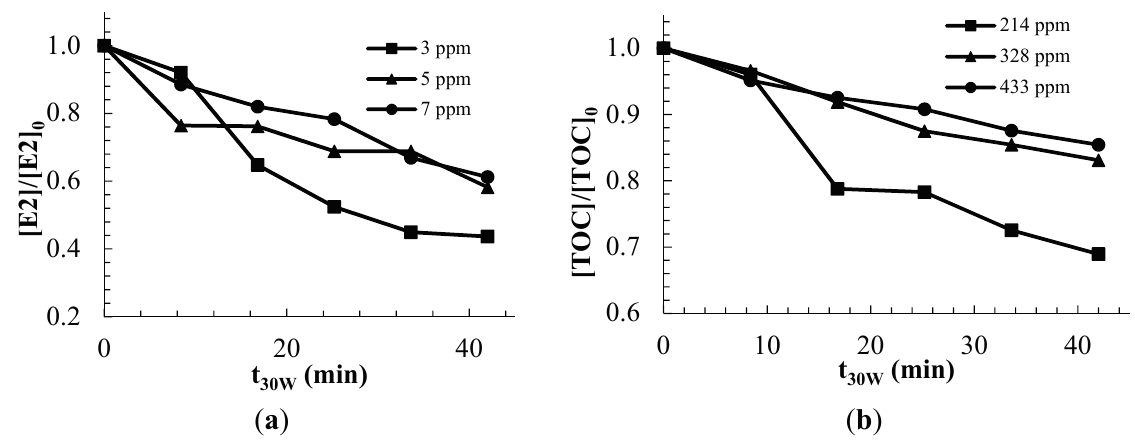
Figure 5. Effect of the initial concentration of the contaminant on the degradation rate with a catalyst load of 0.6 g/L; ( a ) Estrogens degradation; ( b ) TOC removal. The estrogens removal was 56.7%, 41.7% and 38.7% for 3, 5 and 7 ppm of initial estrogens concentration, respectively, which means that the removal rates (ppm/min) increased as the initial estrogen concentration increased, whereas the TOC removal was 31.1%, 16.9% and 14.6% for 214,